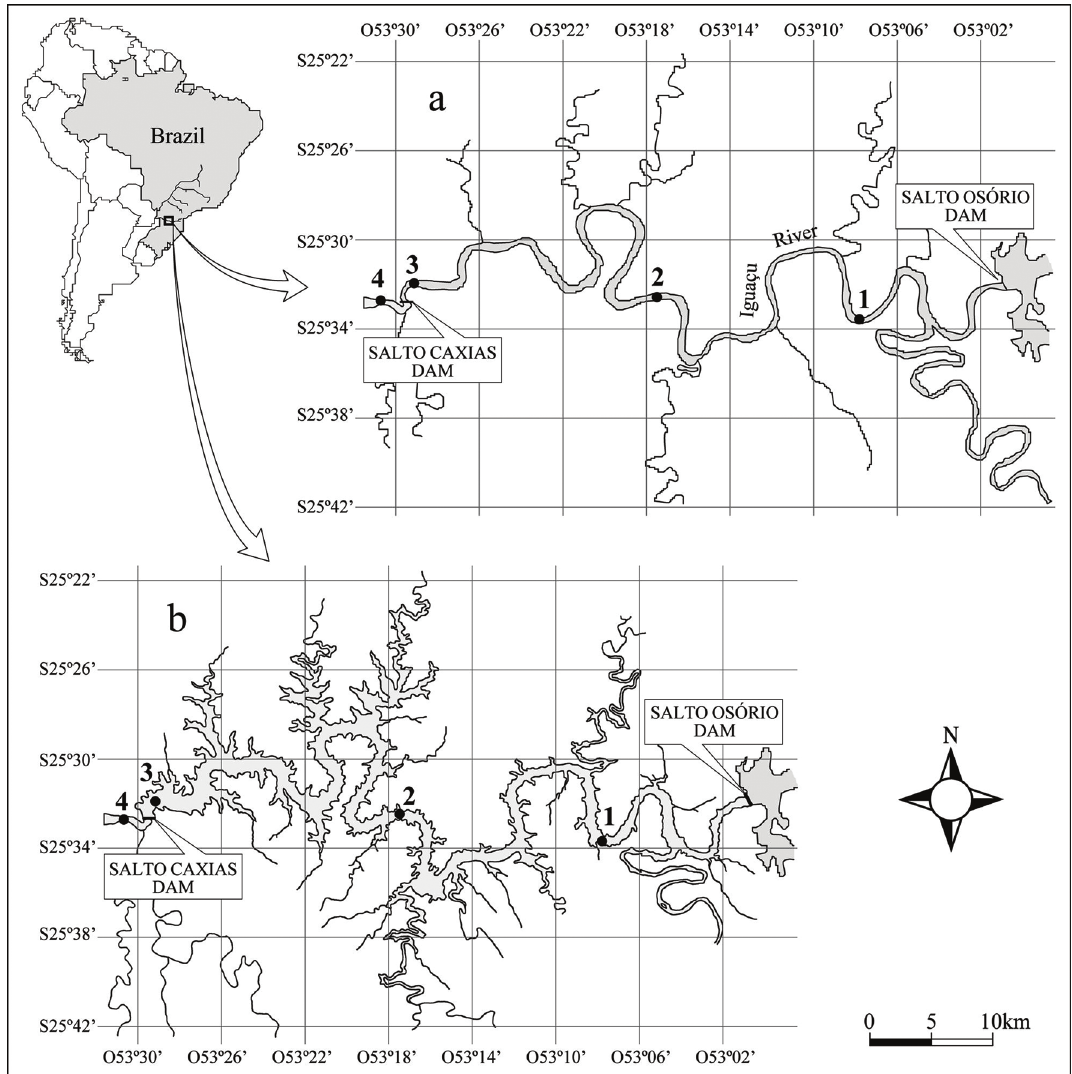
Fig. 1. Location of sampling sites along the longitudinal gradient of the Iguaçu River, in the area influenced by the Salto Caxias Reservoir, Paraná State. a) before the impoundment; b) after the impoundment. (site 1 = upstream; site 2 = middle region; site 3 = dam; site 4 =